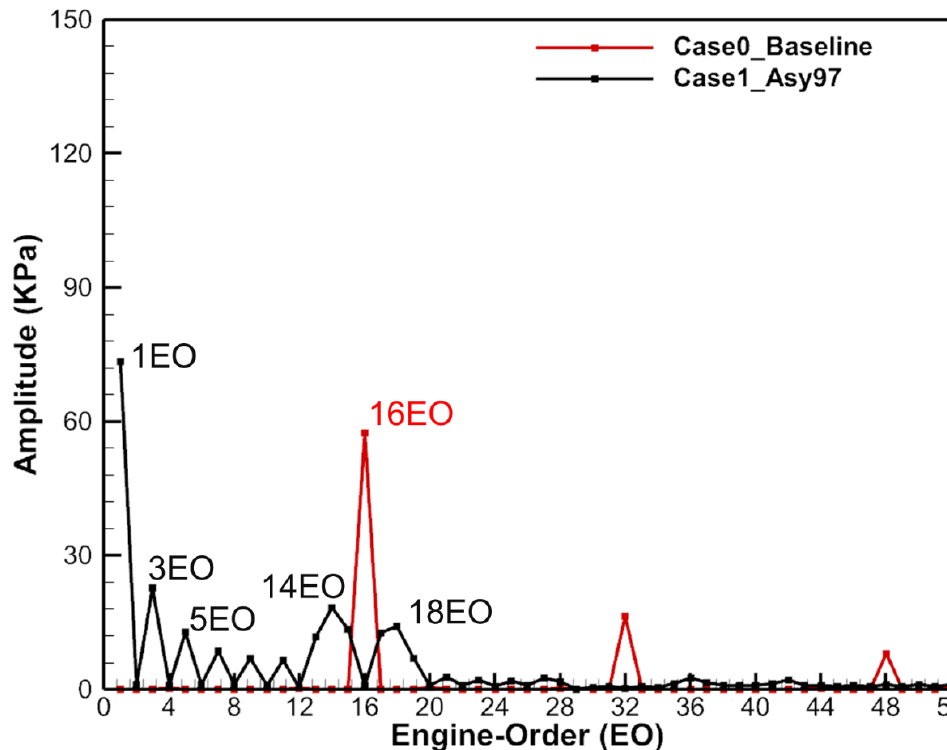
Figure 8. Frequency spectra of fluctuating pressure at monitoring point P.